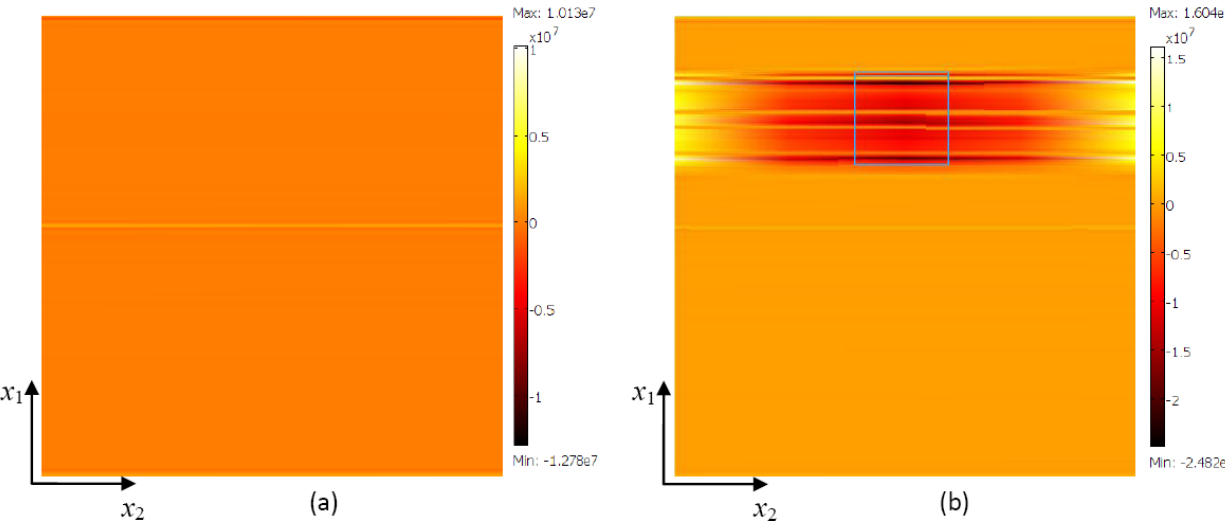
Figure 4. Simulation results: Normal stress σ plane, the entire top surface of the segment considered in the simulation is shown) obtained for different heights of pillar ( a ) h = 0 µm (no pillar), ( b ) h = 10 µm, ( c ) h = 12 µm, ( d ) h = 23 µm, ( e ) h = 34 µm, and ( f ) h = 36 µm. The contact surface of the pillar is shown in